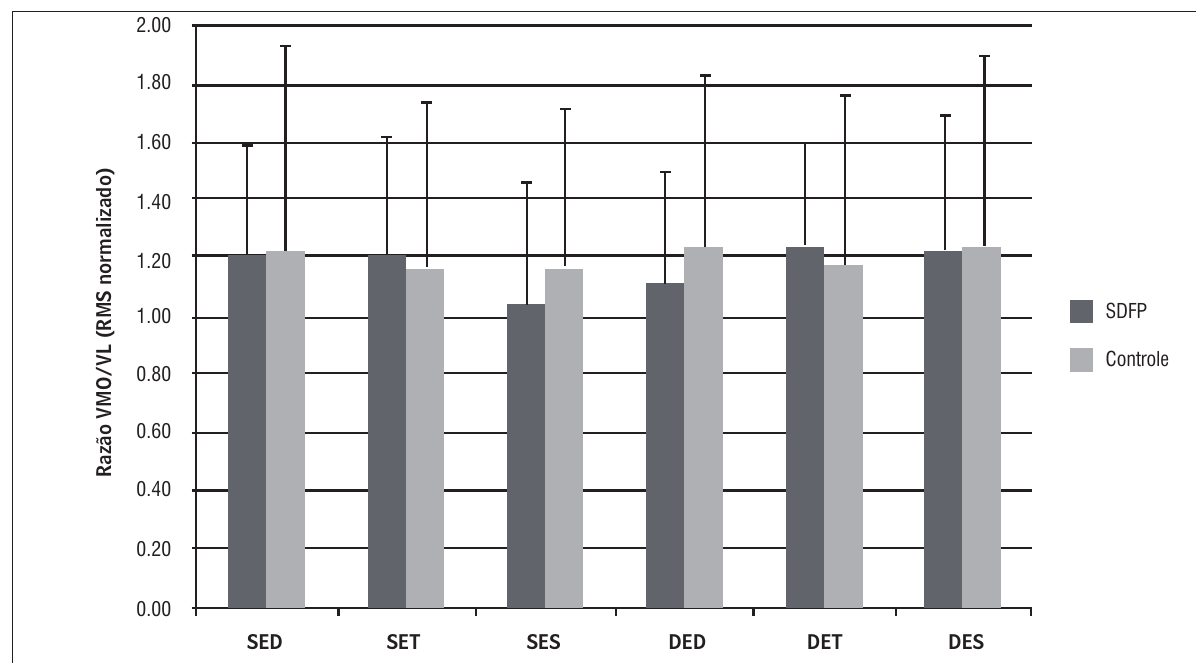
SETSED SES DED DET DES Gráfico 1 - Razão entre os músculos vasto medial oblíquo (VMO) e vasto lateral (VL) para os grupos controle e SDFP durante as atividades de subir e descer